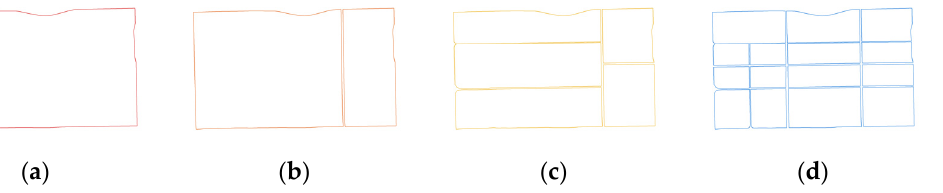
Figure 4. Induction pattern of natural street parcels. ( a ) initial state. ( b ) 1st breaks. ( c ) 2nd breaks. ( d ) final state.